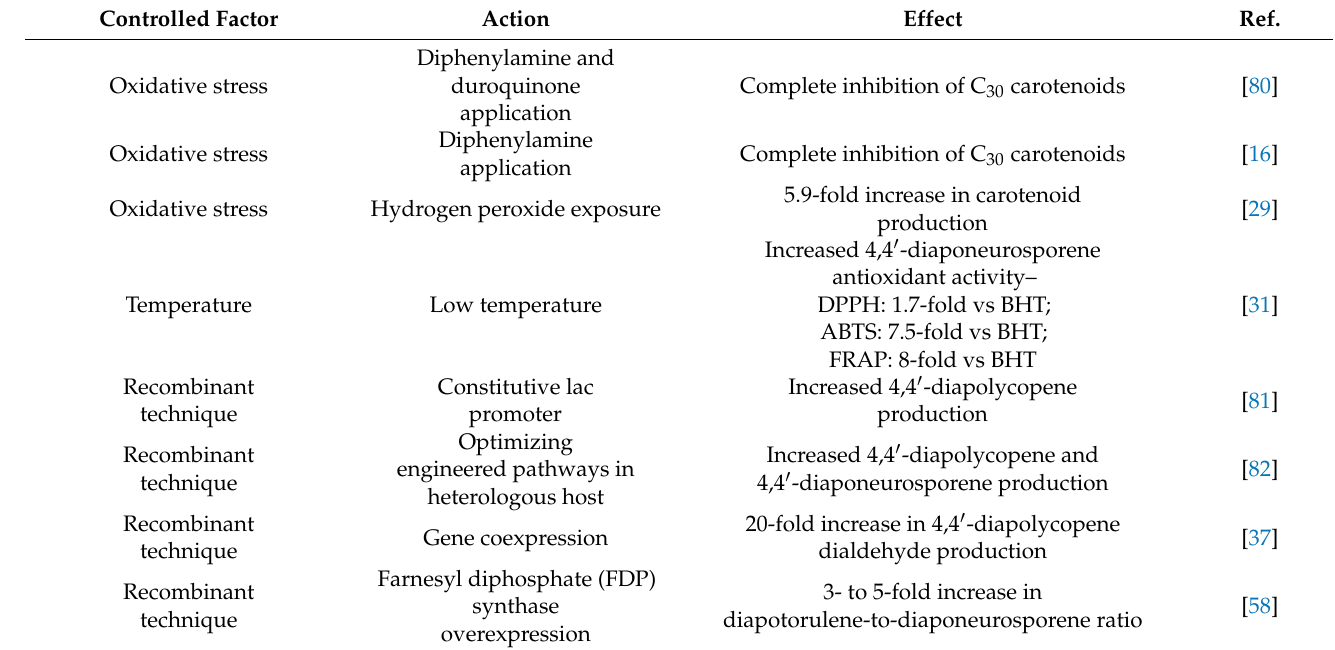
Table 2. Effects of applied factors on C 30 carotenoid